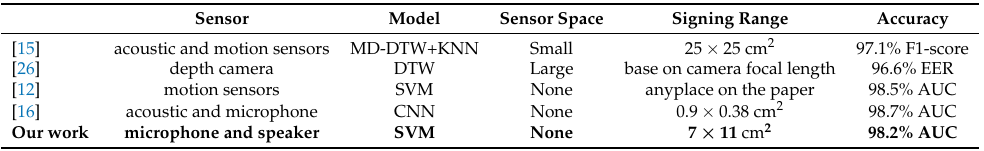
Table 4. Comparison of various signature verification